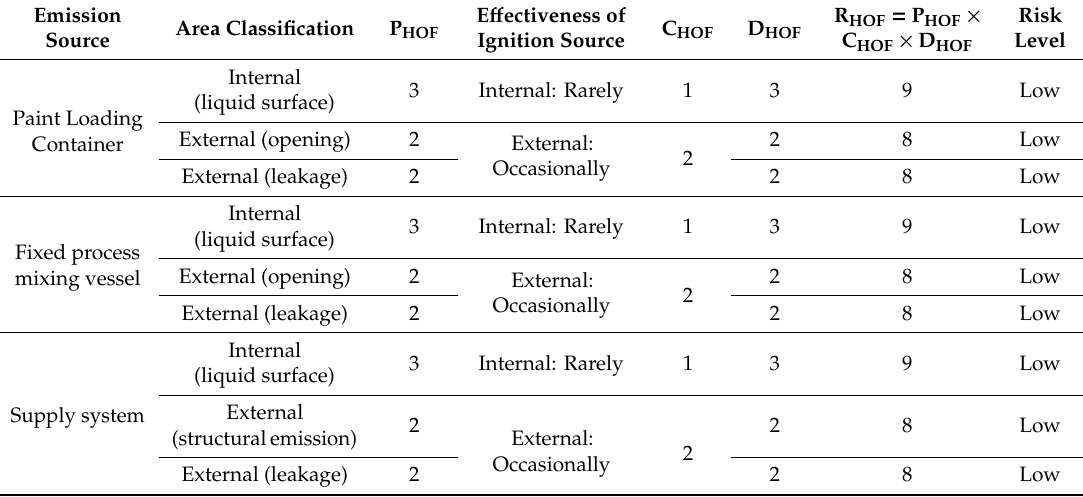
Table 16. ATEX-HOF risk evaluation result for the basic paint mixing